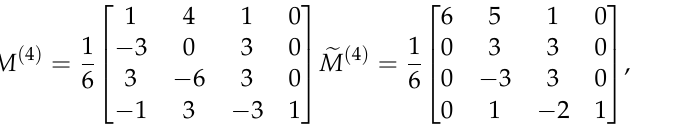
time stamps of IMU data acquisition and LiDAR data acquisition time stamp, respectively.